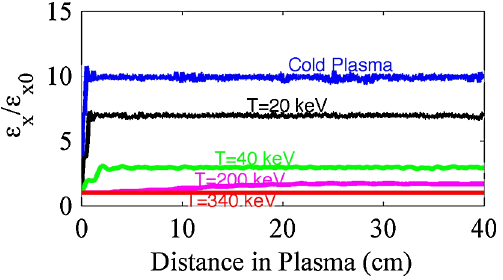
FIG. 5. Relative emittance growths ( " x =" x 0 , " x 0 ¼ 0 : 1 mmmrad incoming emittance) along the plasma for the various plasma ion temperatures of Figs. 3 and